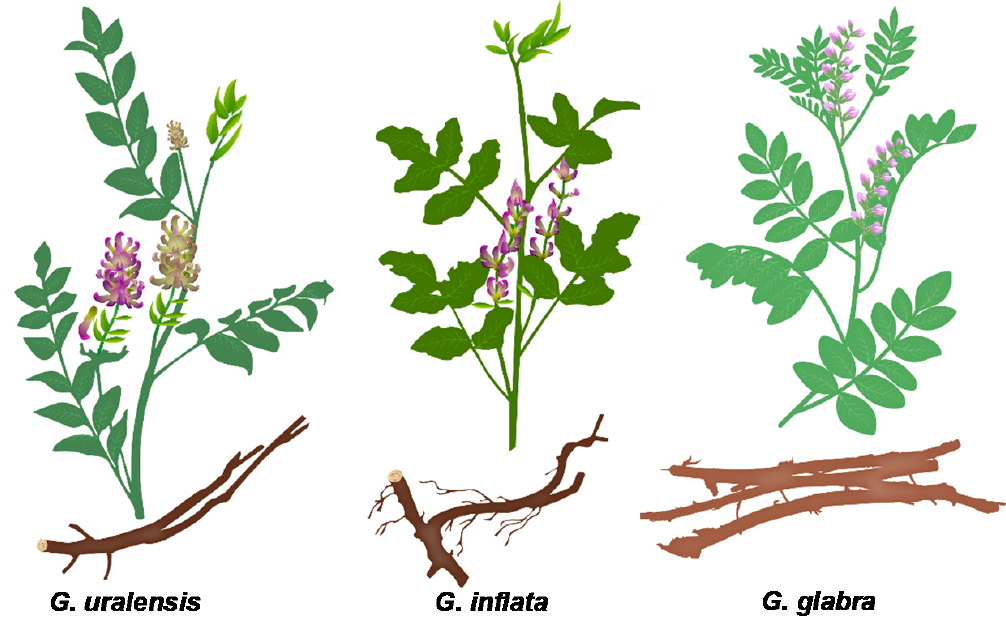
Figure 1. Schematic drawing of the three congeneric Glycyrrhiza species.